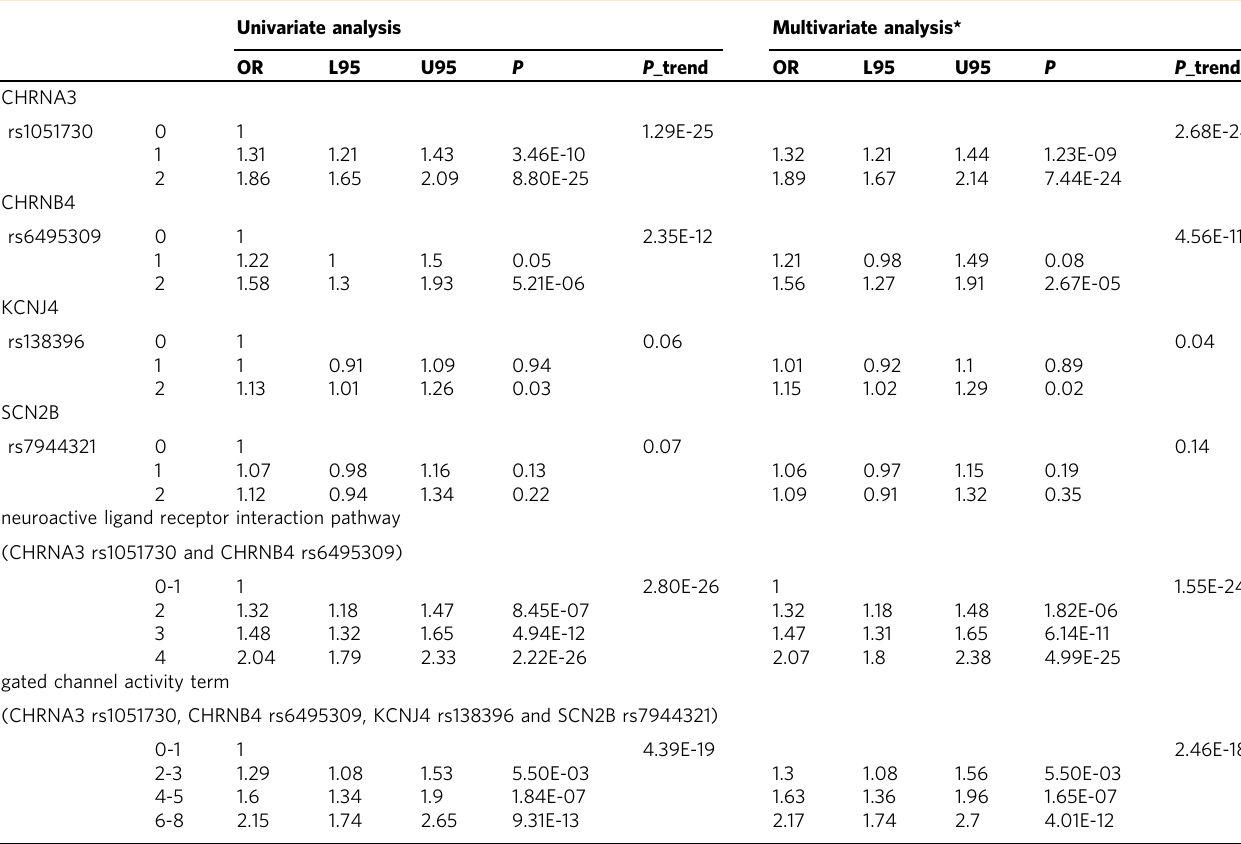
Table 5 Individual and combined effects of SNPs from our susceptibility pathways on lung cancer risk in the meta-analysis of Discovery